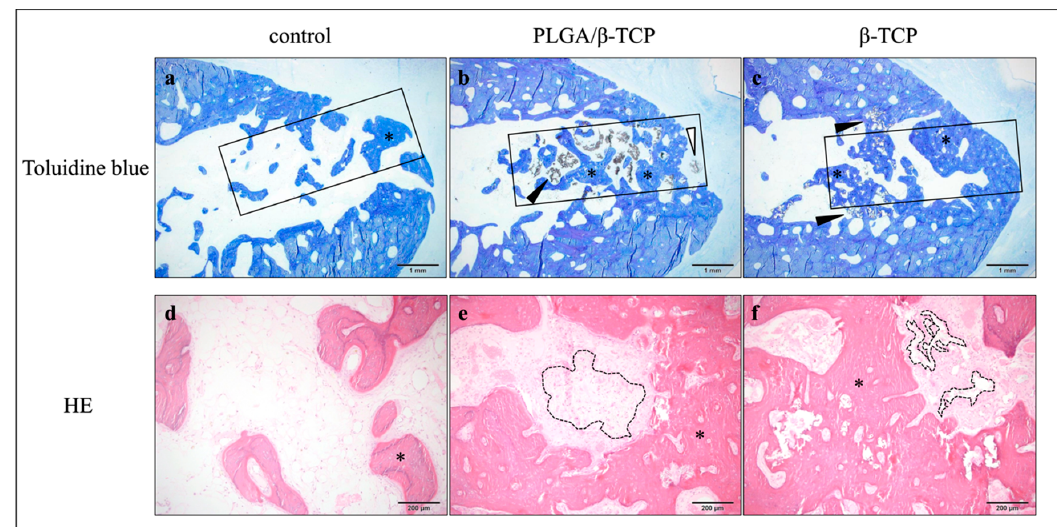
Figure 3. Quantitative histomorphometric analysis.